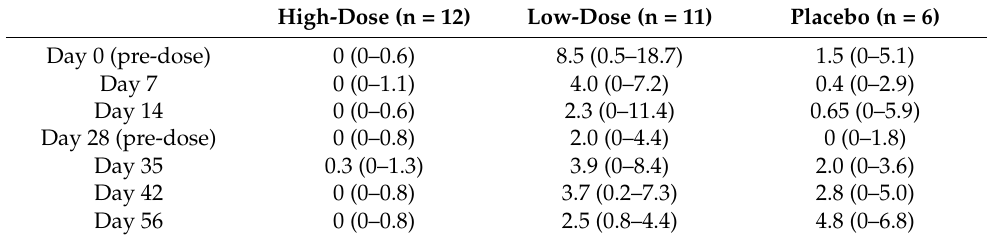
Table 5. Summary of anti-RBD IgG titre in serum.